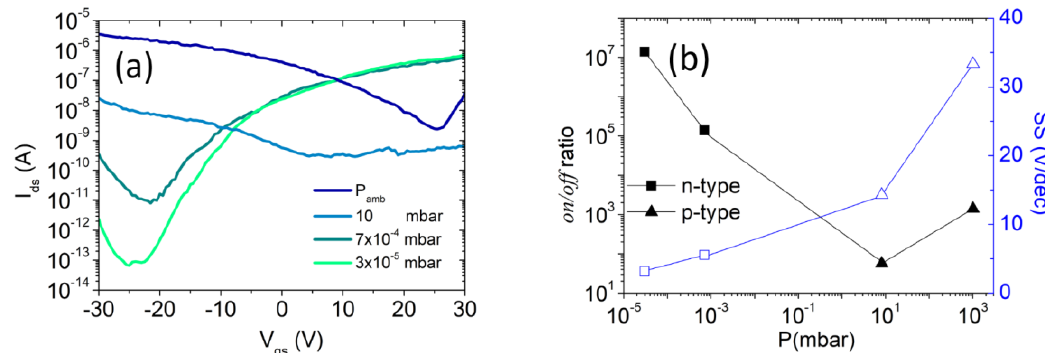
Figure 4. ( a ) Transfer characteristics at different pressures from atmospheric value (blue curve) to ∼ 10 −5 mbar (light green curve) ( b ) On/Off ratio (full marks, left scale) and subthreshold swing (empty marks, right scale) as a function of the chamber pressure.